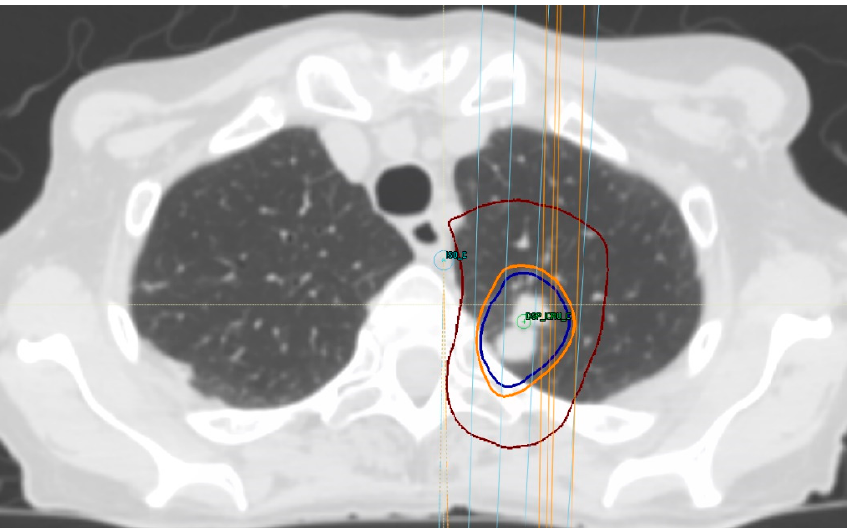
Figure 2. Treatment-planning dose for lung SBRT in a patient with biopsy-proven metastatic breast cancer, prescribing 48 Gy in four fractions. Isodose lines: Burgundy, 24 Gy; light orange, 44 Gy; and blue, 48 Gy.